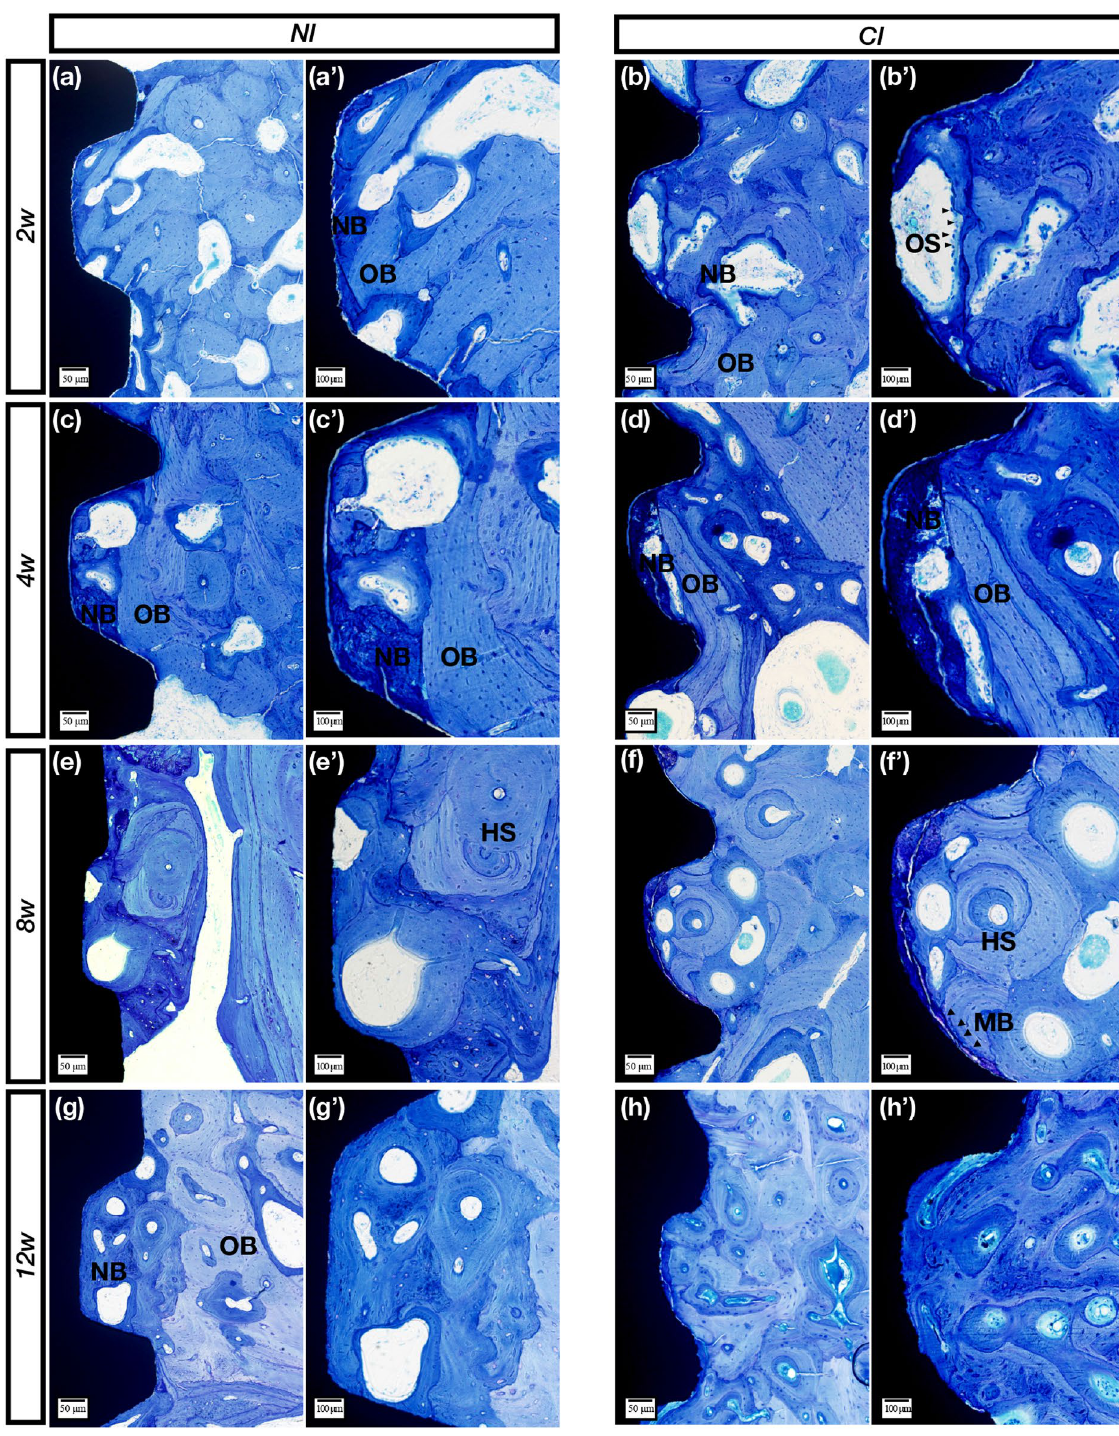
Figure 3. Toluidine blue staining. ( a , a ′ ) Clearly, the new and old bone of the NIs is alternately meshed in the threads in the 2nd week. ( b , b ′ ) For the control group, a large piece of irregular bone resorption sag appeared on the control implant surface due to the activities of some osteoclasts (black arrows). ( c , c ′ ) In the 4th week, some NB with partial bone resorption formed on the surface. ( d , d ′ ) In the 4th week, NB (dark blue staining) was evident on the CI surface. ( e , e ′ ) In the 8th week, the Haversian system (HS) was observed, and the cellular components disappeared. ( f , f ′ ) Mineralized bone (black arrows) deposited around the control implants, and NB gradually matured. ( g , g ′ ) The boundary between new and old bone became more blurred, and NB gradually matured after 12 weeks. ( h , h ′ ) The bone around the control implants was dominated by mature bone at 12 weeks. OS (osteoclasts); NB (new bone); OB (old bone); (HS) Haversian system; (MB) mineralized bone. Scale bars represent 50 μm ( a – h ) and 100 μm ( a ′ – h ′ ); original magnification: ( a – h ) × 10, ( a ′ – h ′ ) ×